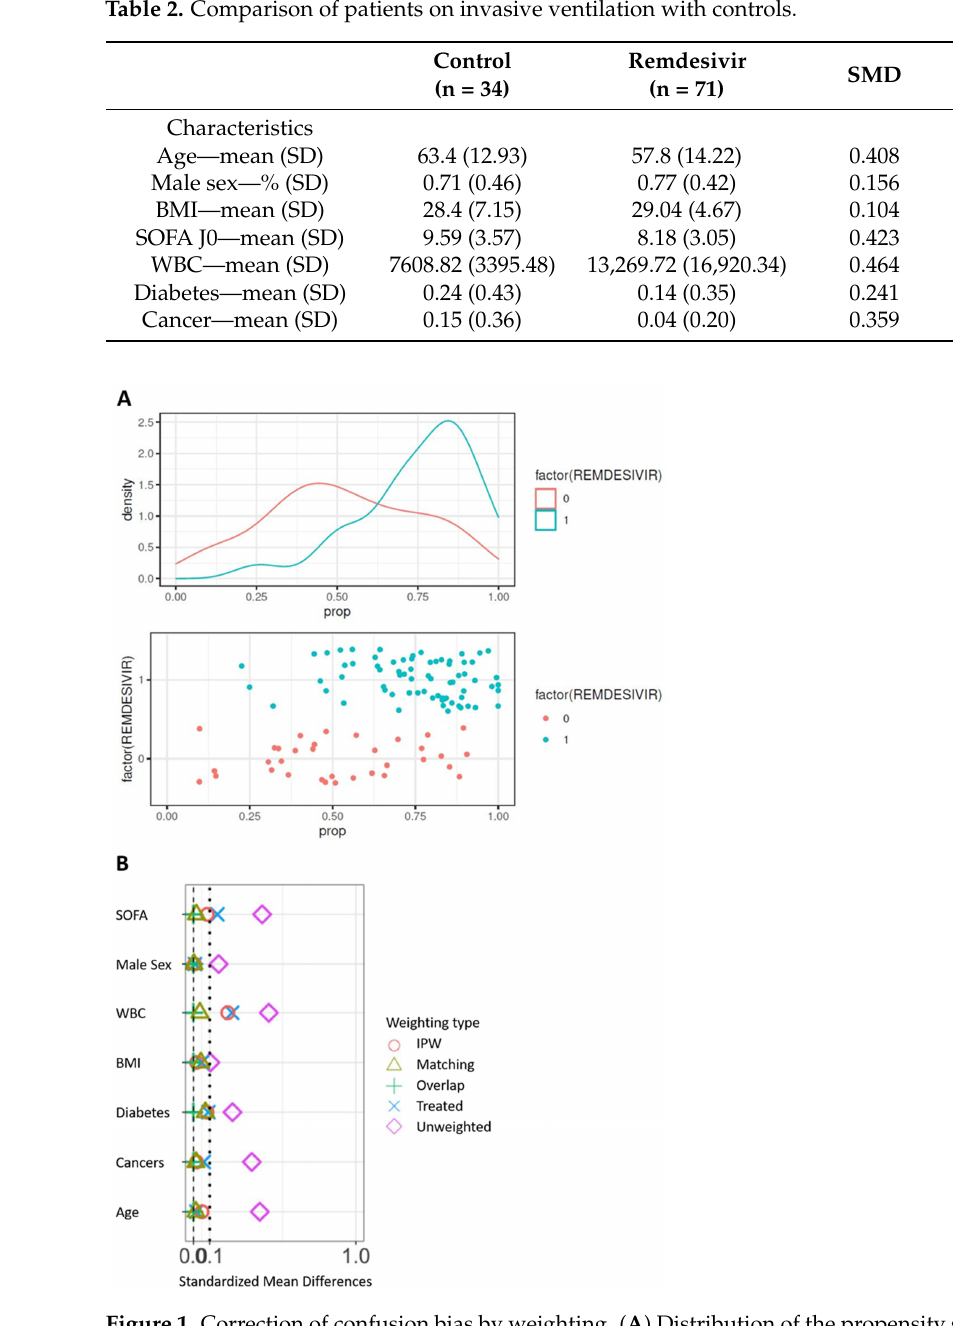
Figure 1. Correction of confusion bias by weighting. ( A ) Distribution of the propensity score between groups on the original basis. ( B ) Correction of the imbalances according to the types of weighting. WBC, white blood cells; BMI, body mass index.